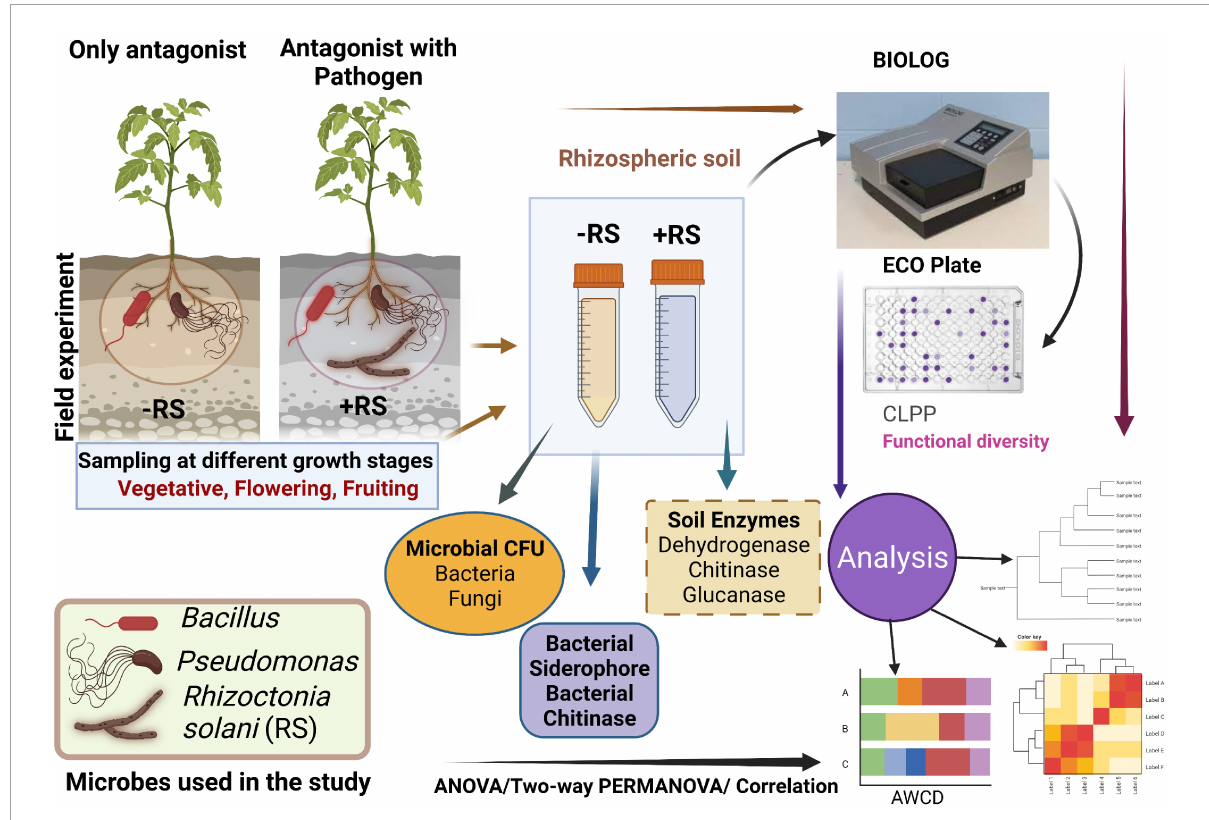
FIGURE1 Schematic representation of the present study. CFU-Colony forming unit, CLPP- community-level physiological